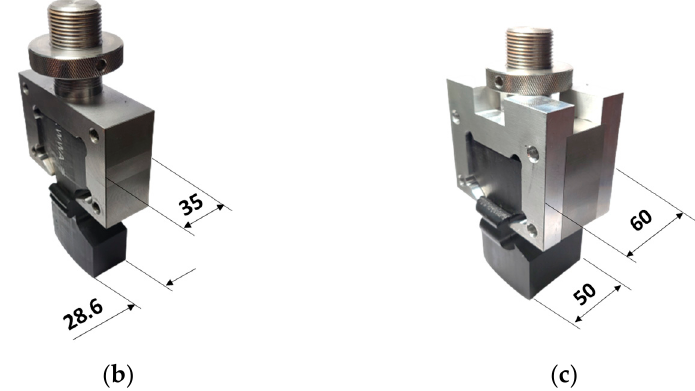
Figure 5. ( a ) Assembly of push-in grip and TWT specimen; ( b ) example of 315 SDR 11 (single-grip assembly for t ≤ 30 mm specimens); ( c ) example of 450 SDR 9 (multi-layering of grip assembly for testing thicker specimens of t > 30 mm) (unit: mm).